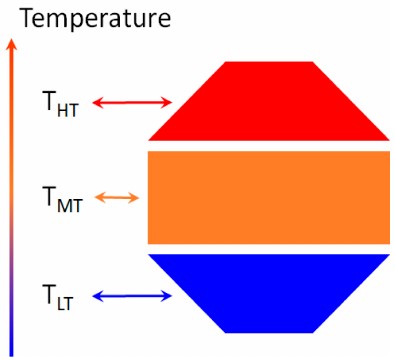
Figure 2. Schematic of a trithermal adsorption device